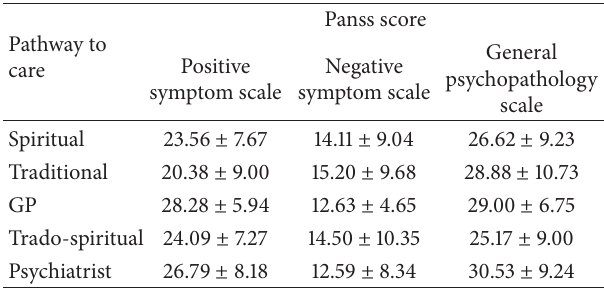
Table 4: The PANSS score of participants according to their specific pathways to